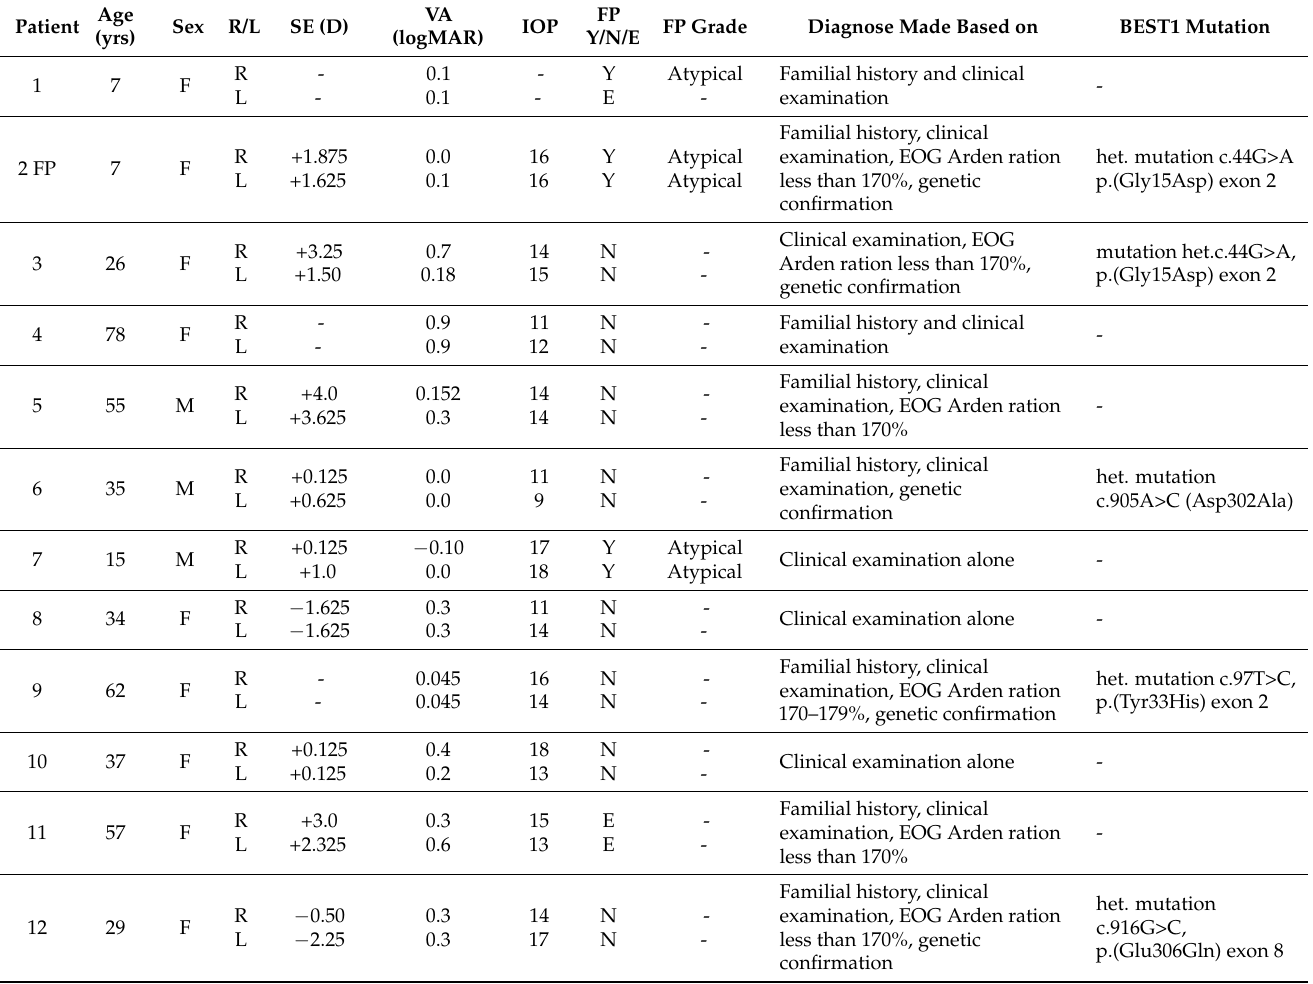
Table 1. Patient’s details and